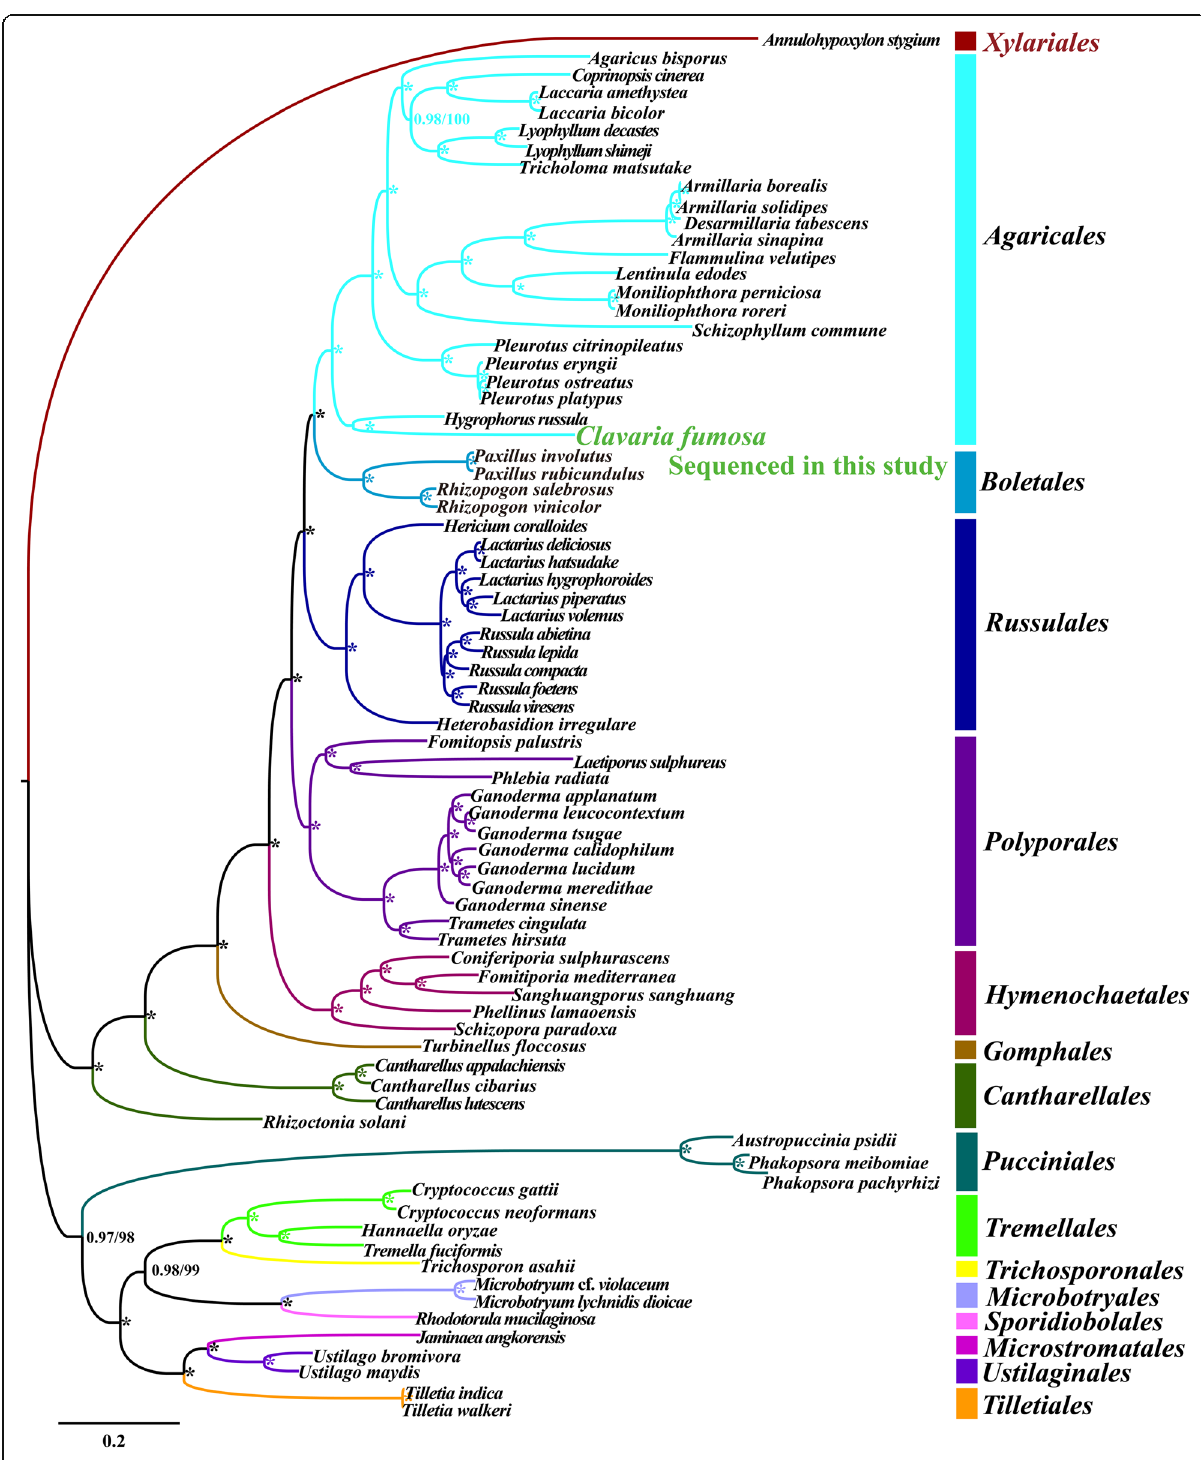
Fig. 7 Molecular phylogeny of 76 Basidiomycota species based on Bayesian inference (BI) and Maximum likelihood (ML) analysis of 15 protein coding genes and two rRNA genes. Support values are Bayesian posterior probabilities (before slash) and bootstrap (BS) values (after slash). The asterisk indicates that the BPP value is 1 and the BS value is 100 of the branch. Species and NCBI accession numbers for mitogenomes used in the phylogenetic analysis are provided in Supplementary Table